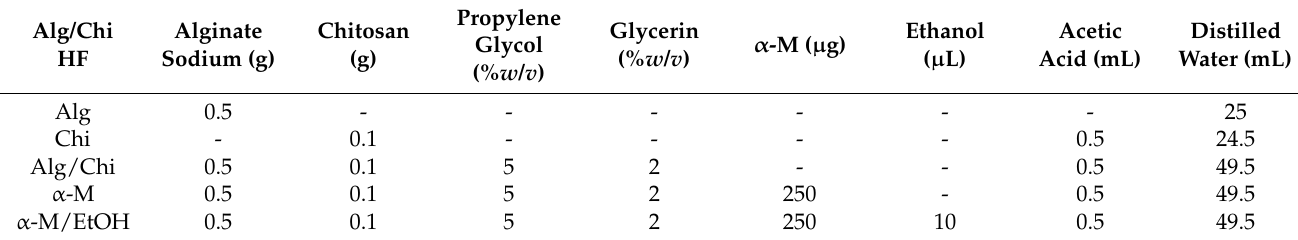
Table 1. Preparation of α -M/EtOH Alg/Chi HF.